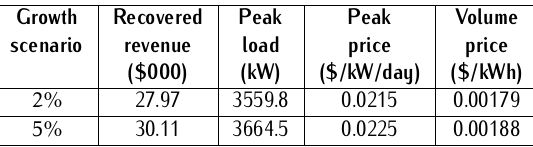
Table 6. Peak price and volume price